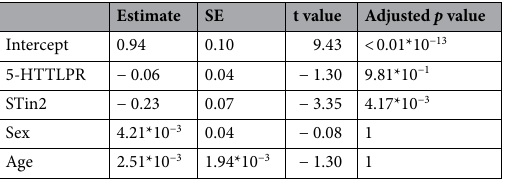
Table 8. General linear model for risk of SCZ using 5-HTTLPR and STin2.